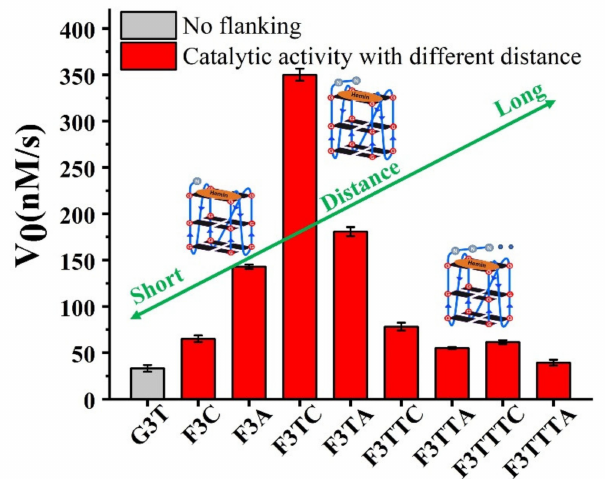
Figure 4. The e ff ect of distance from catalytic synergy group (dC or dA) to iron porphyrin center on catalytic activity of G4 / Hemin DNAzyme. Experiments were carried out in 10 mM Tris-HCl bu ff er (pH = 7.0, with 100 mM KCl, 0.05% Triton X-100, 1% DMSO,) at 25 ◦ C with 0.4 µ M G4, 0.6 mM H2O2, 0.6 mM ABTS and 0.8 µ M